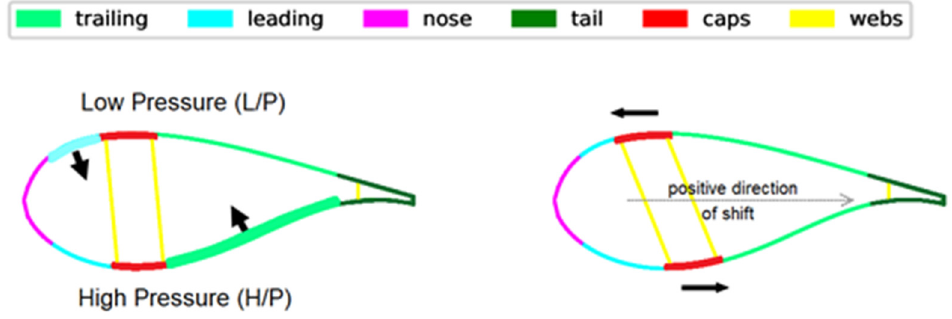
Figure 1. Definition of blade cross-section, demonstrating the material ( left ) and geometrically ( right ) based FEC through appropriate asymmetric thickness increase or displacement of the spar caps.